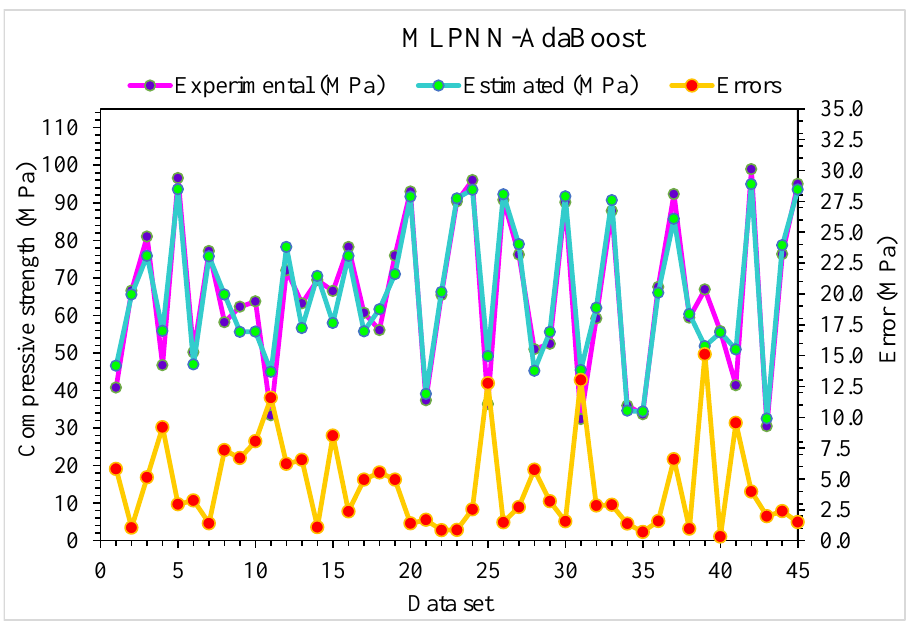
Figure 9. Experimental and MLPNN-AdaBoost predicted values with errors for compressive strength. The MLPNN-AdaBoost model ’s estimated and investigational results were com- pared for SFRC flexural strength (Figure 10). MLPNN-AdaBoost depicts reduced varia- tion in error for SFRC flexural strength and highly precise predicted results. The adequacy of the MLPNN-AdaBoost model is represented by an acceptable R 2 of 0.94. The error dis- tribution of MLPNN-AdaBoost predicted and experimental SFRC flexural strength is il- lustrated in Figure 11. The average error value for SFRC flexural strength is 1.57 MPa: 47% of total error values are below 1 MPa, 53% of these values are between 1 and 5 MPa, and no value is more than 5 MPa.